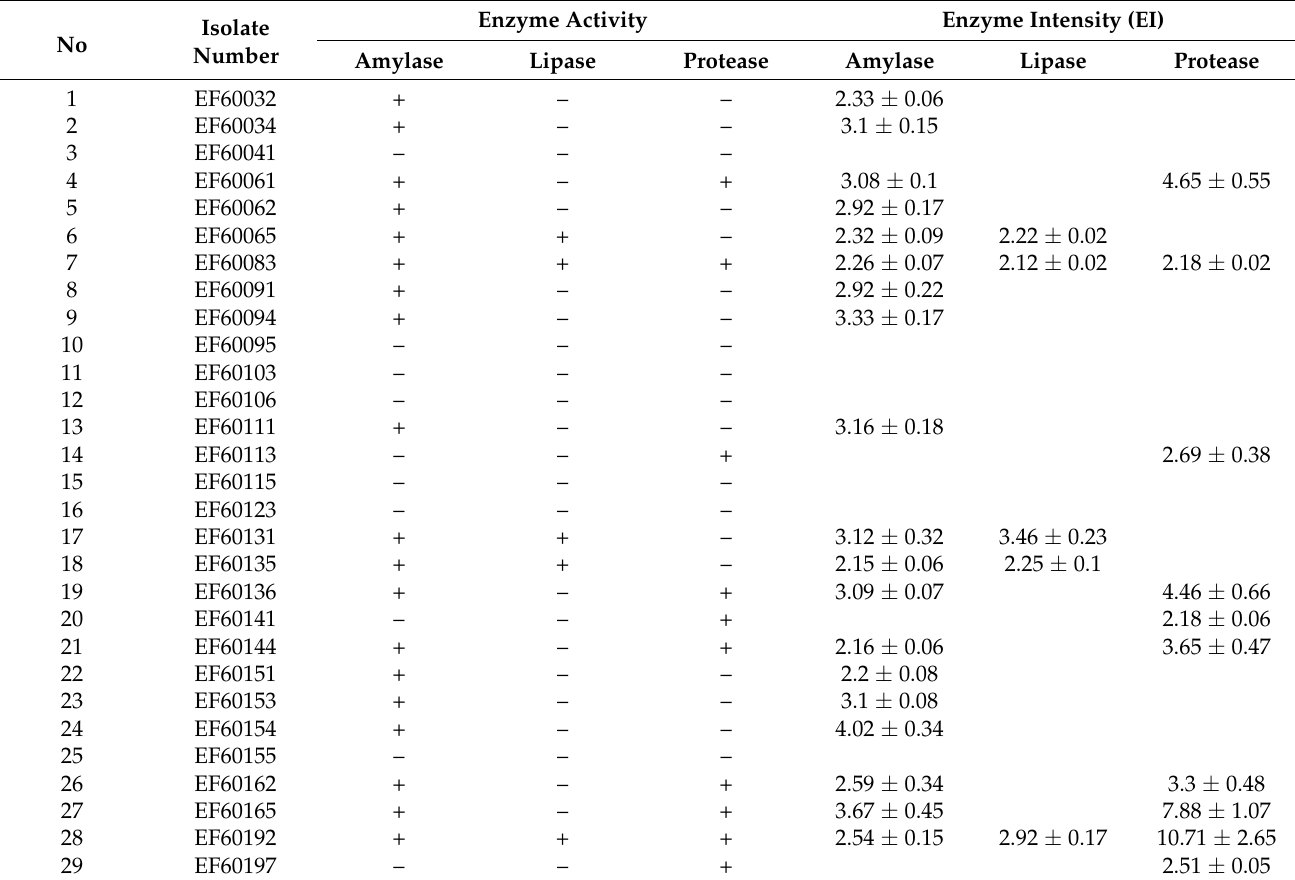
Table 5. Amount of extracellular hydrolases produced by thermophilic isolates expressed as